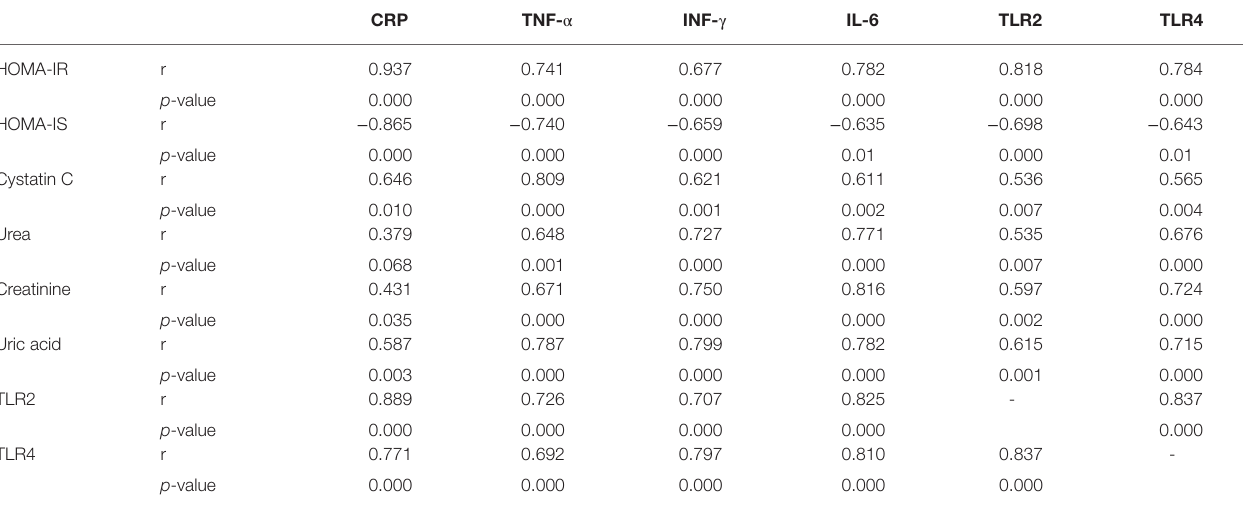
TABLE 3 | Correlation analysis between inflammatory mediators, insulin resistance, and kidney function parameters. CRP TNF- α INF- γ IL-6 TLR2